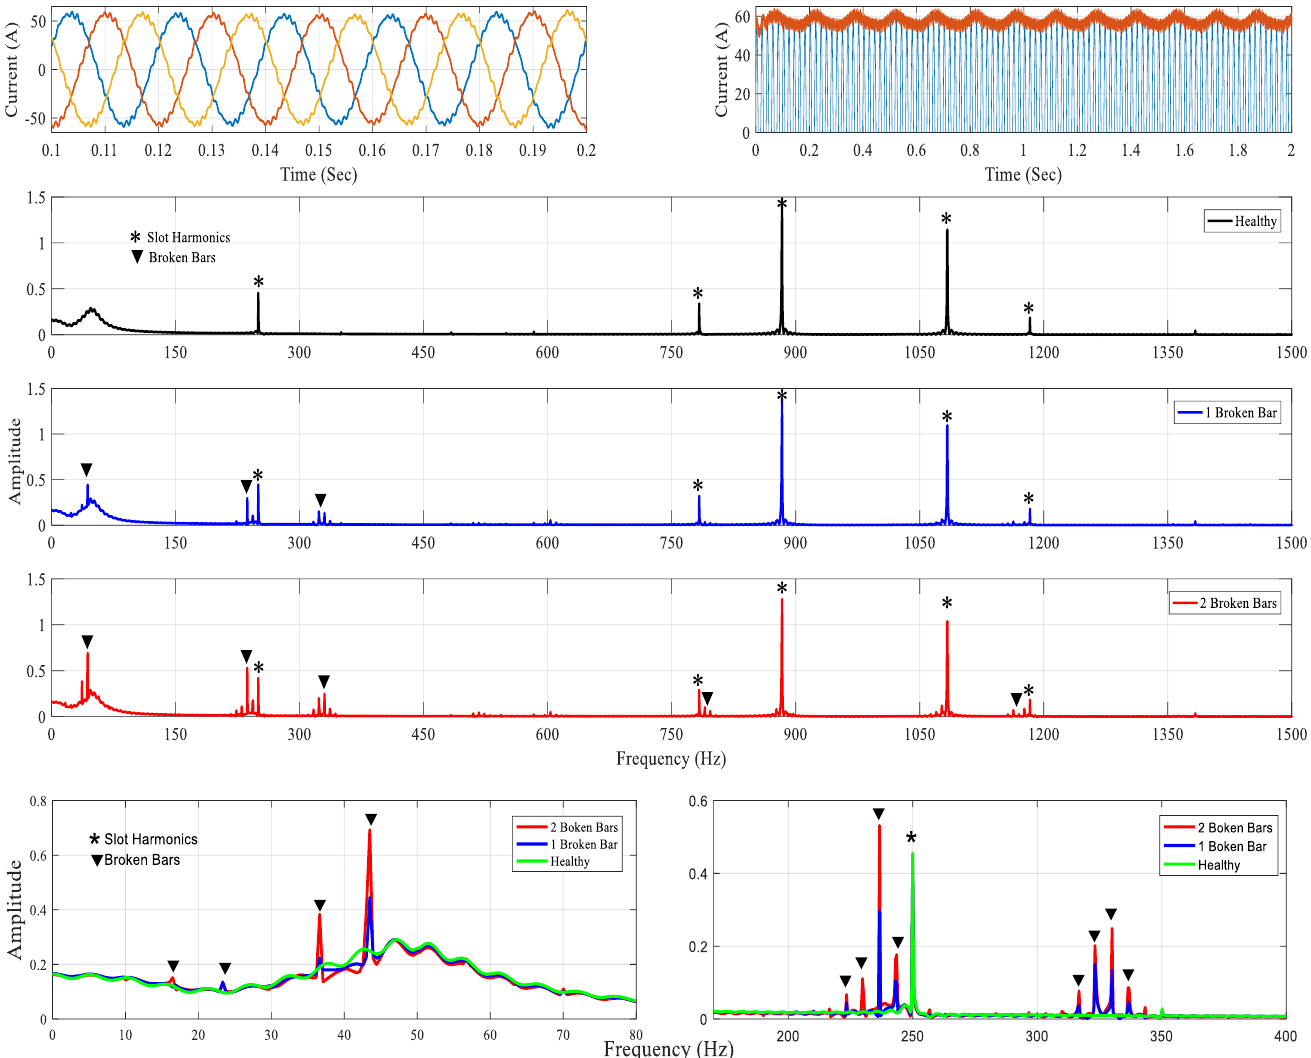
Fig. 4. Simulation results; three phase current in top left, per phase current and its envelope for three broken bars in top right, frequency spectrum for healthy, 1 broken and 2 broken bar cases from top to down; zoomed comparison of harmonics for healthy and faulty motors in bottom two